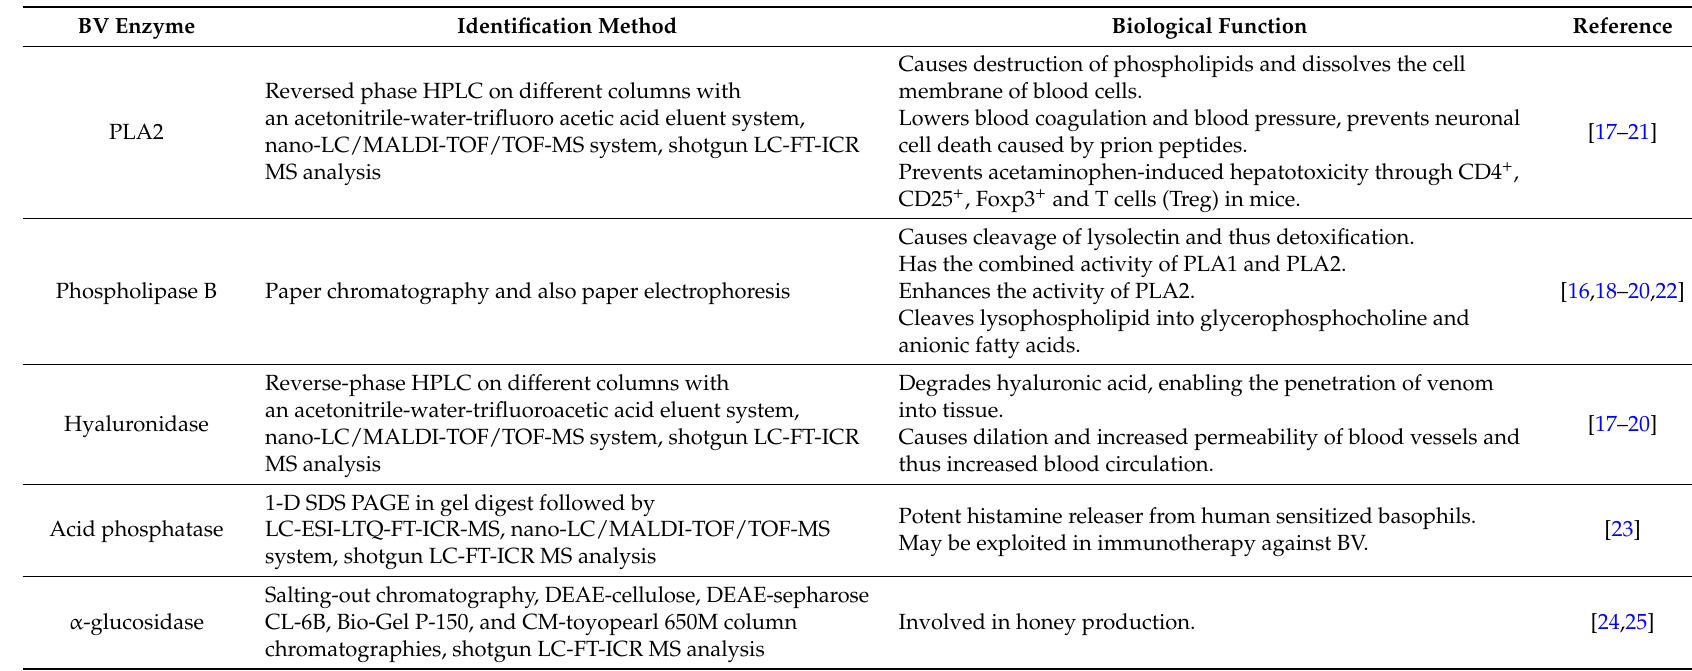
Table 1. Identification methods and biological functions of recognized BV